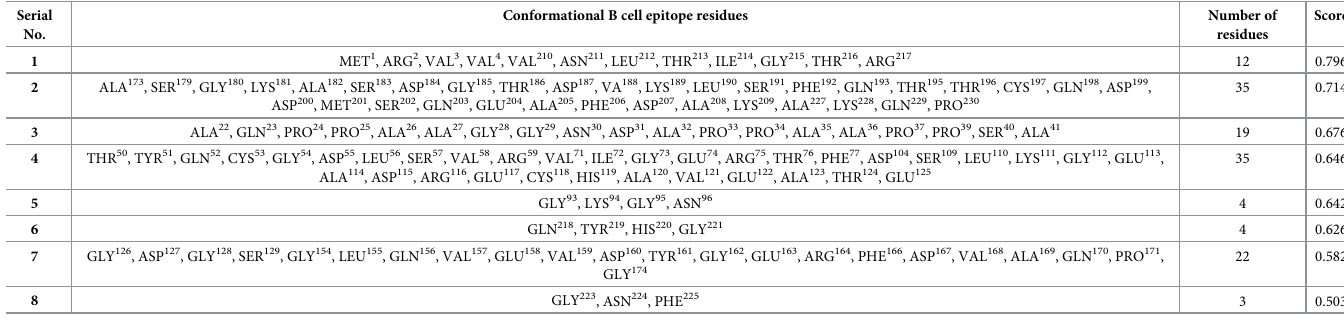
Table 12. Amino acid residues of the conformational B cell epitopes. Serial